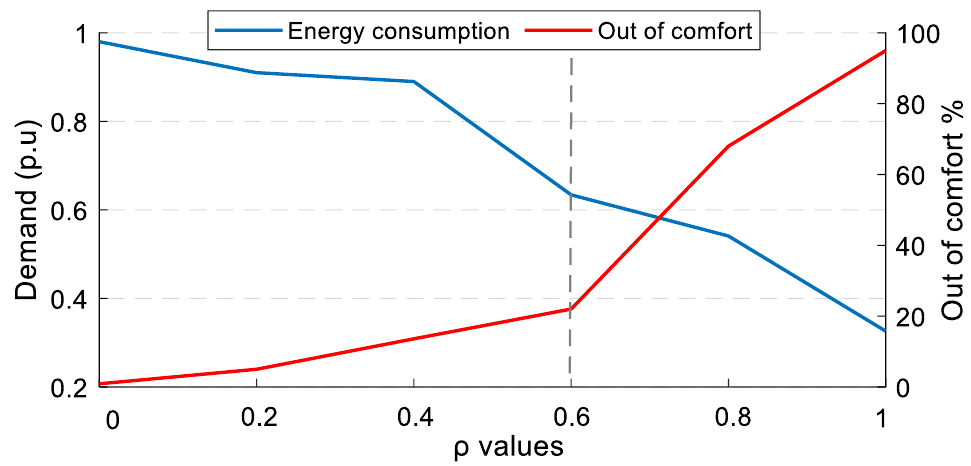
Figure 11. Comfort and energy-saving trade-offs.